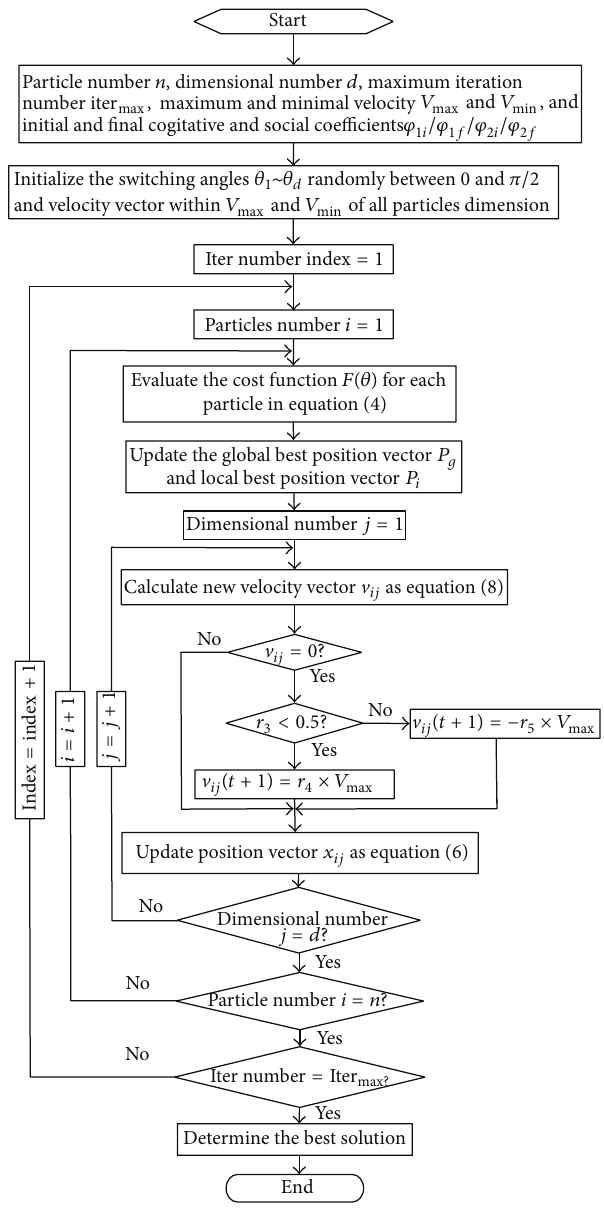
Figure 2: Flow chart of HPSO-TVAC applying to harmonic mini- mization